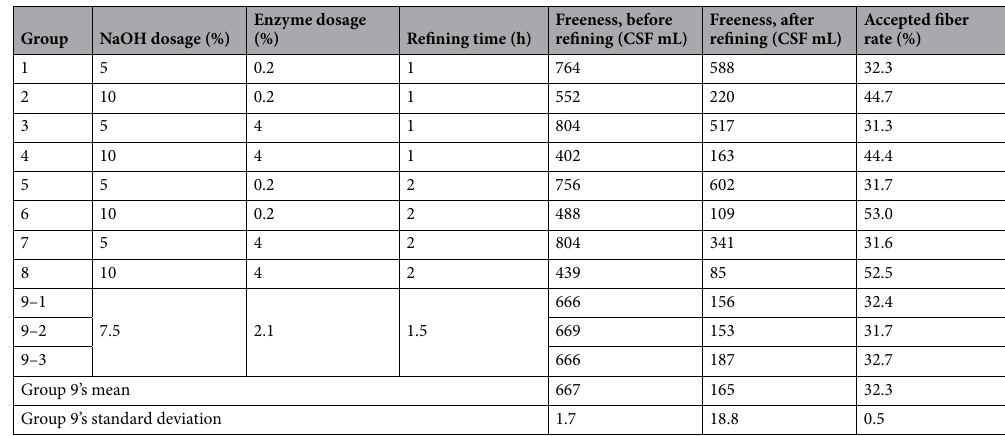
Table 3. The factorial experimental design results of the pulp properties.